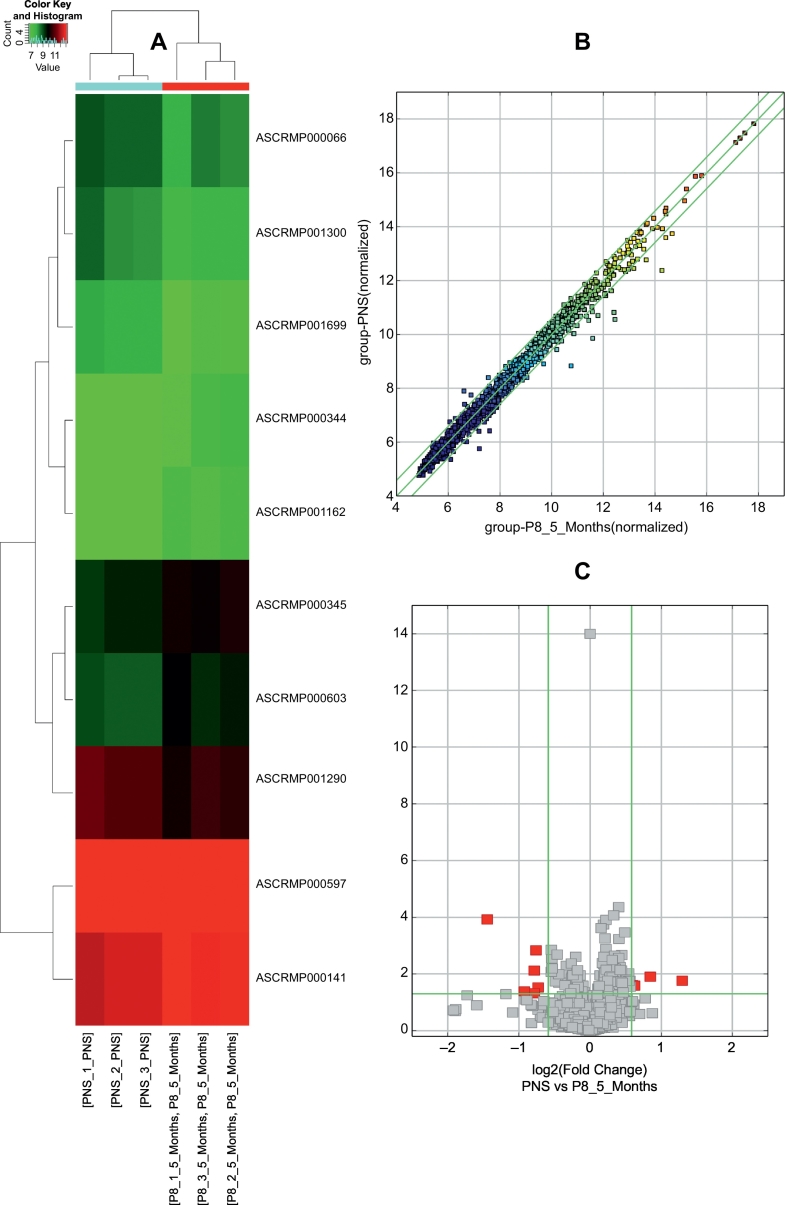
The hierarchical cluster, scatter plot and volcano plot of differential expression of circRNAs in PNS-treated and –untreated SAMP8 mice. A: Hierarchical cluster of differentially expressed circRNAs. “Green” indicates low intensity, “black” indicates medium intensity and “red” indicates strong intensity. B: Scatter plot of circRNA signal values. The values of X and Y axes represents the normalized signal values of the samples (log2 scaled) and the averaged normalized signal values of samples (log2 scaled) respectively. The green lines are fold change lines. The CircRNAs above the top green line and below the bottom green line demonstrates >1.5-fold change of circRNAs between the two compared samples. C: Volcano plot of differential expression of circRNAs. The vertical lines correspond to 1.5-fold up and down, respectively. The horizontal line represents a P-value of 0.05, and the red point in the plot represents the differentially expressed circRNAs with statistical significance.